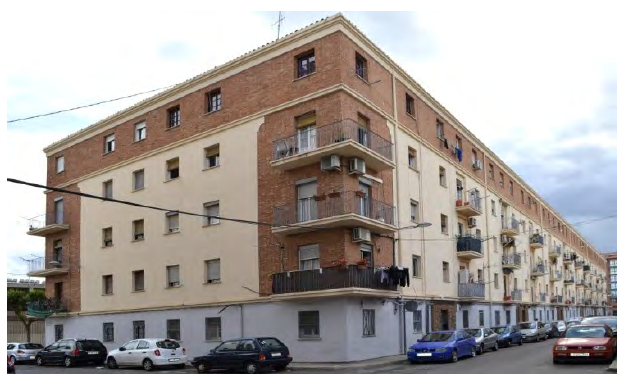
Figure 3. General